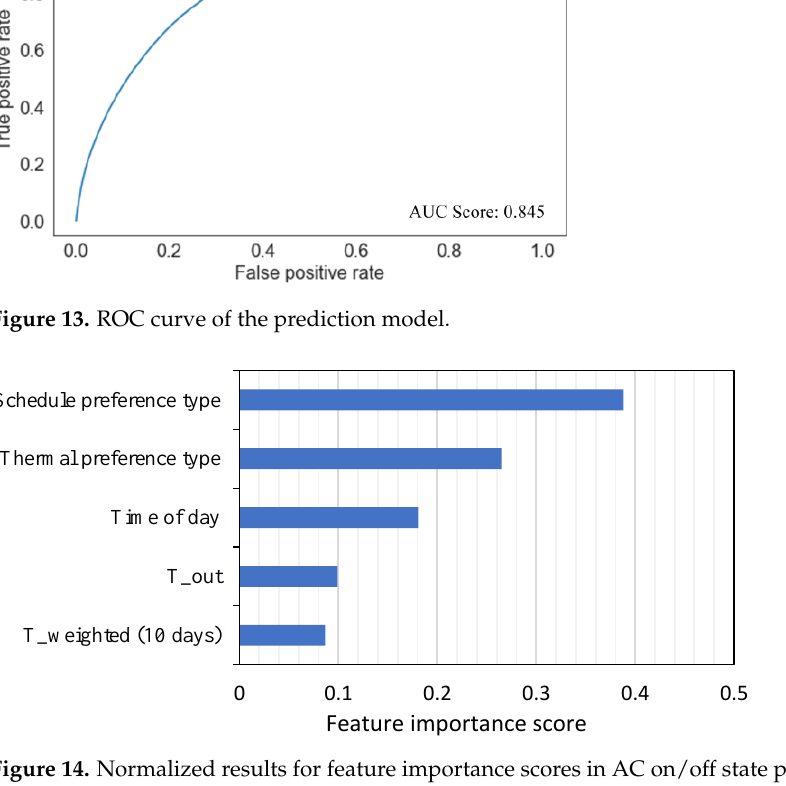
Figure 14. Normalized results for feature importance scores in AC on/off state prediction.